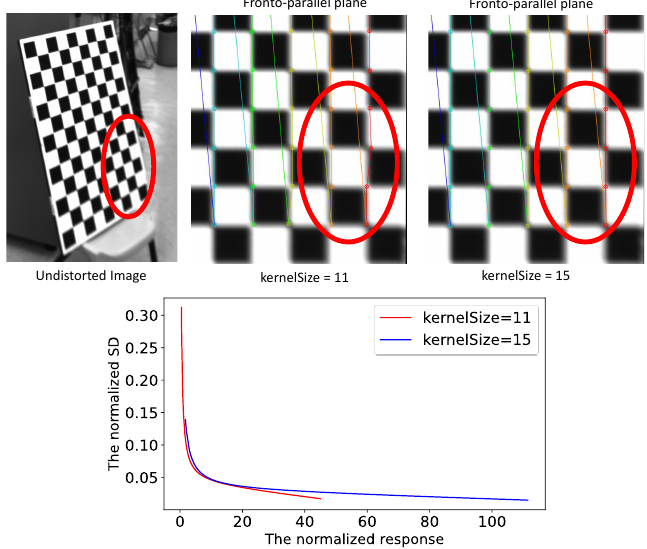
Figure 11. The left-hand image shows the cropped chessboard from an undistorted image. The middle and right-hand images are the fronto-parallel plane versions of the cropped chessboard. The red circles indicate the same image area. The detected control points in the fronto-parallel image showed obvious deviations when the kernel size was 11. The bottom graph illustrates the relationship between the normalized point responses and the normalized standard deviations of the detected control